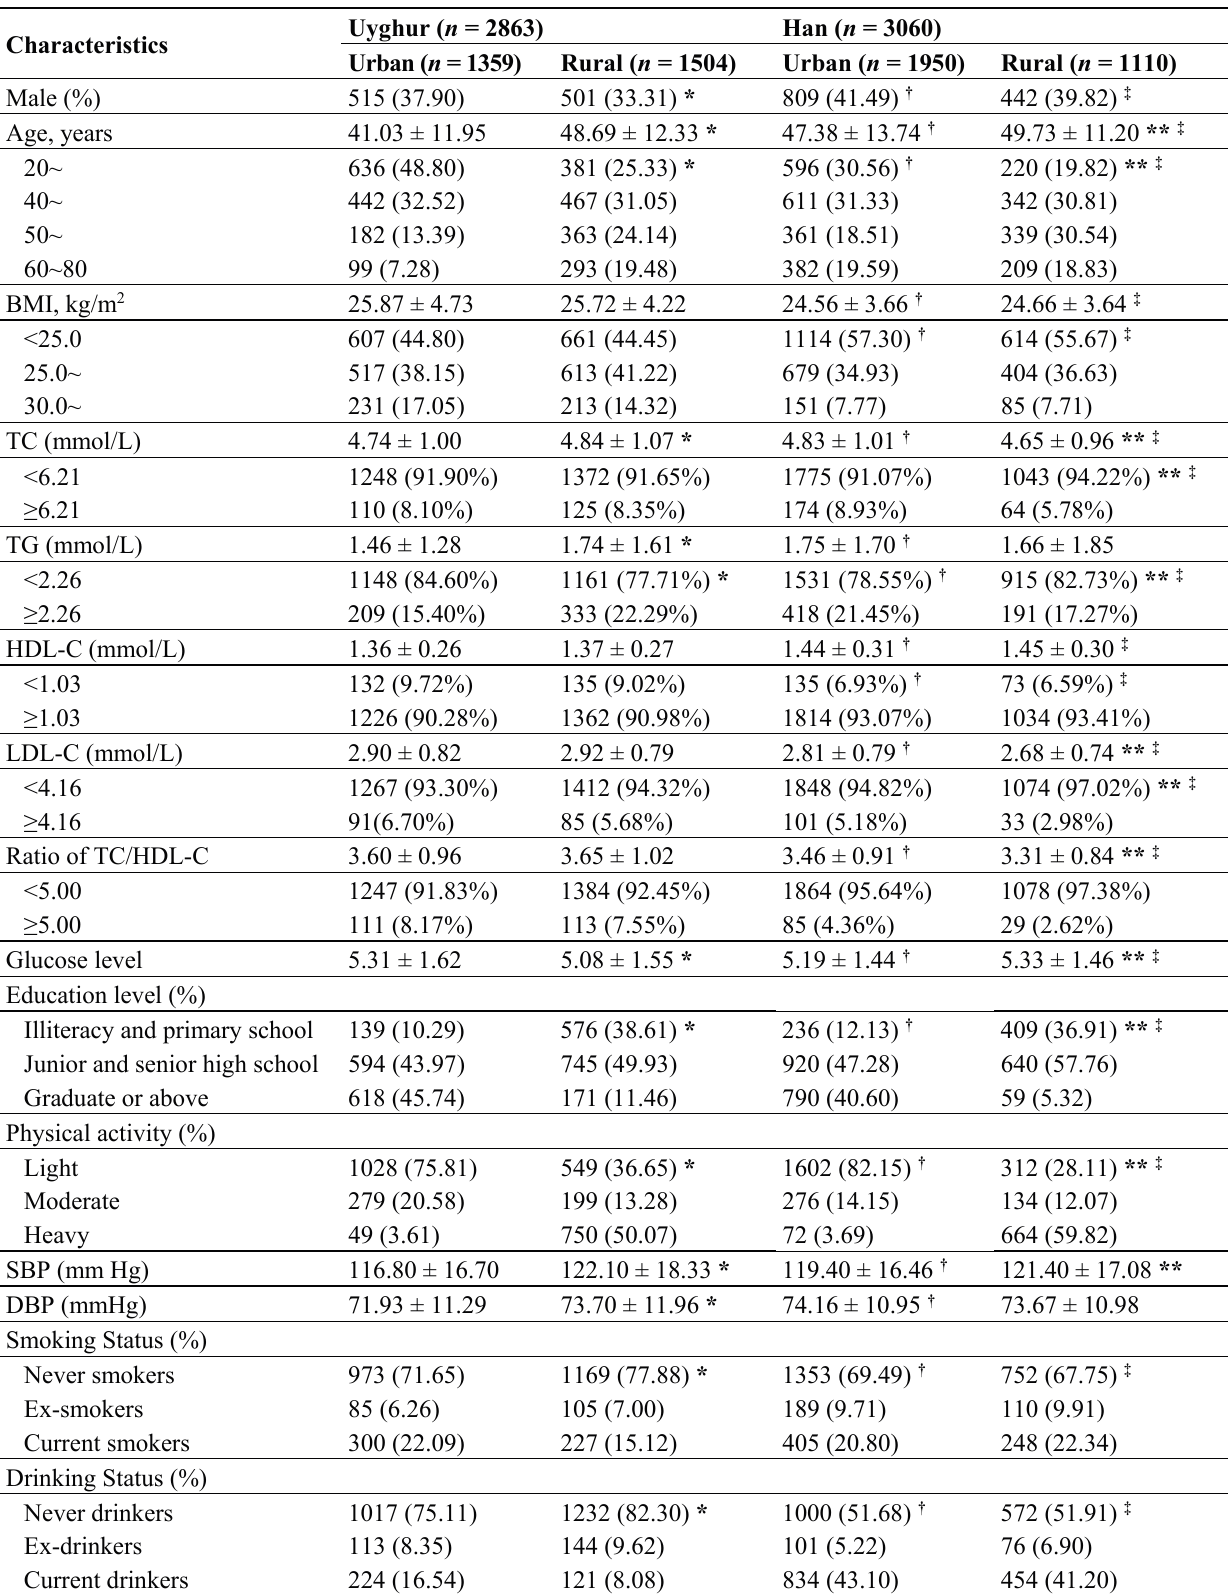
Table 1. Characteristics of Uyghur and Han populations according to